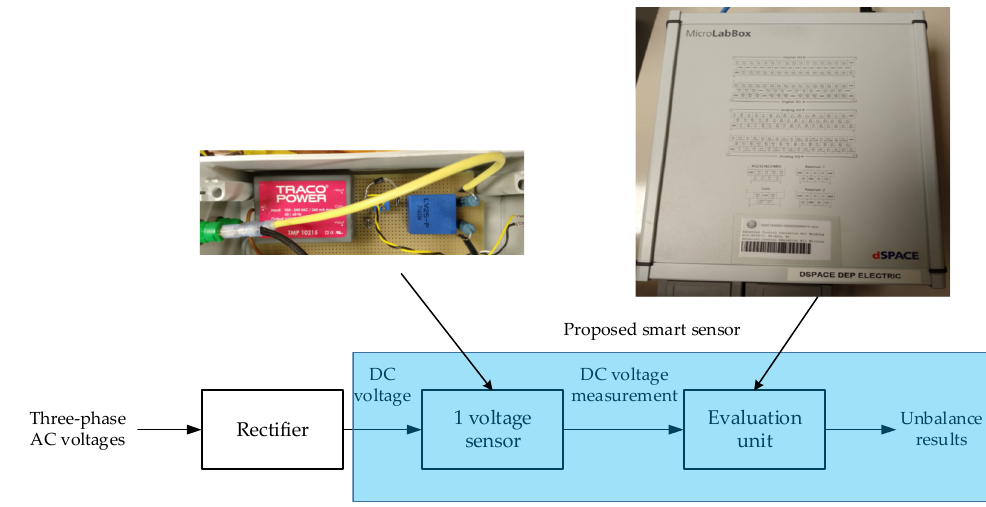
Figure 1. Block diagram with the proposed smart sensor to quantify the VUF.